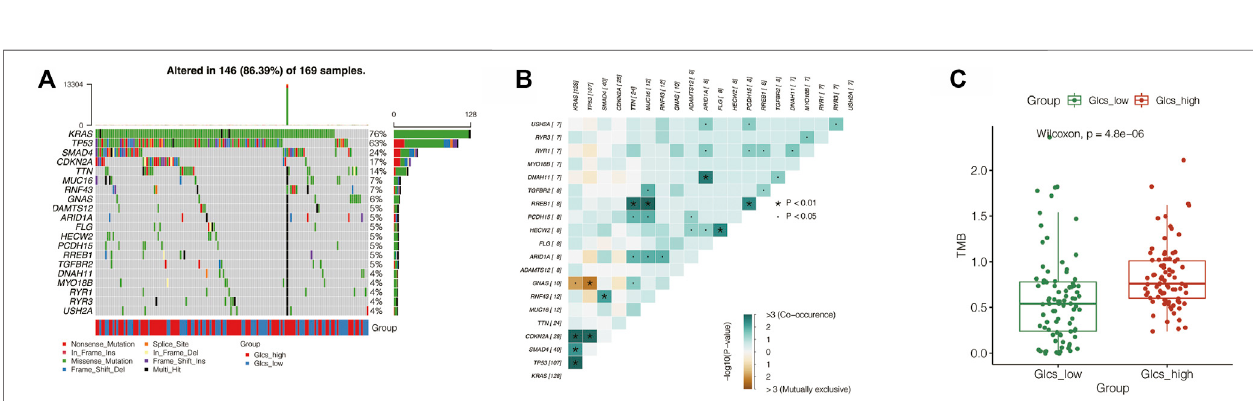
Frontiers in Genetics |